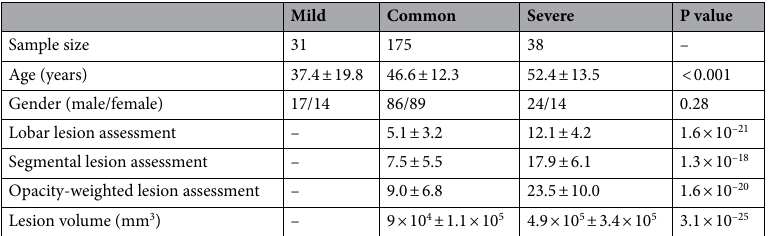
Table 2. The demographic information and lesion loads of each type of COVID-19 patients.